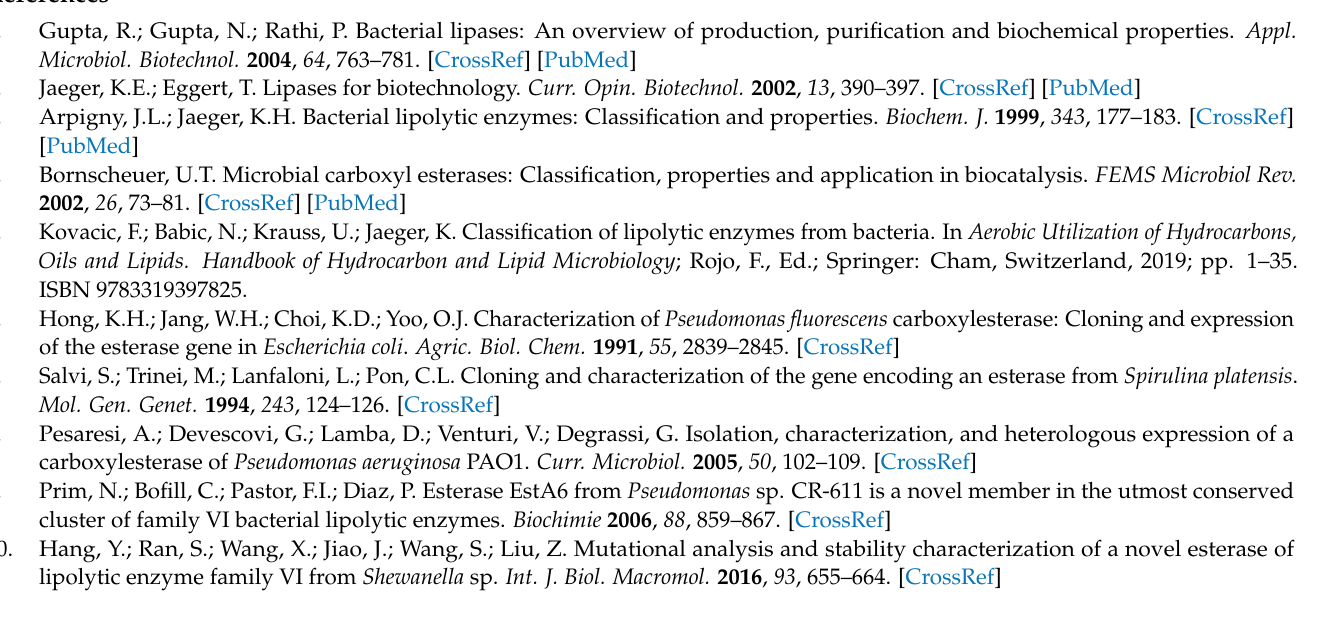
Figure S3: The secondary structure of Est6 predicted by I-TASSER; Figure S4: 3D structural modeling of Est6 by